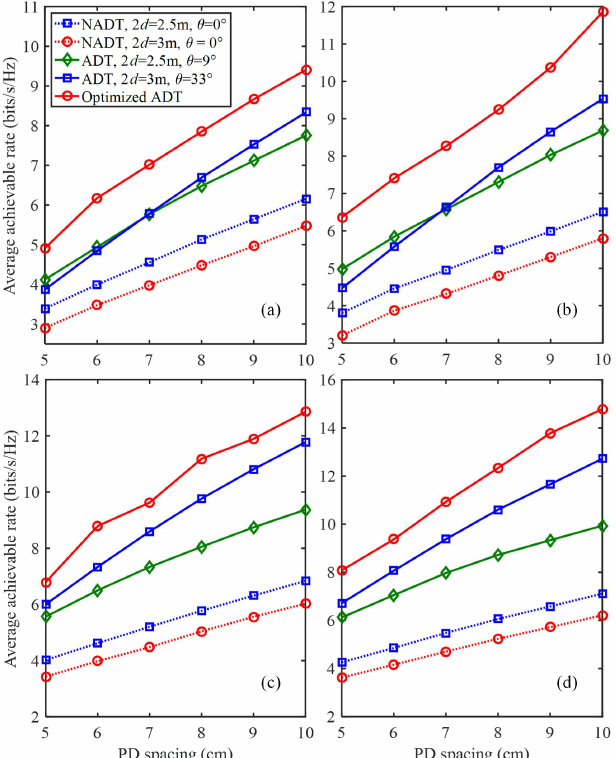
Figure 8. Average achievable rate vs. the spacing between two adjacent PDs in the generalized ADT with different N values for ( a ) N = 4, ( b ) N = 5, ( c ) N = 6 and ( d ) N =